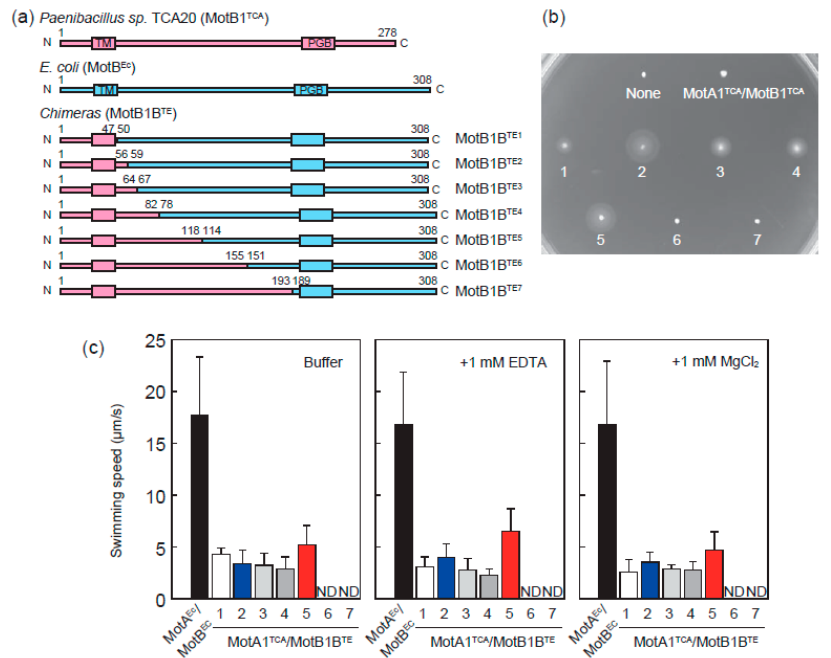
Figure 2. Characterization of chimeric stator in E. coli . ( a ) Design of a series of domain swap chimeras MotB1B TE . The region derived from MotB1 TCA and MotB Ec are colored light magenta and blue, respectively. TM and PGB represent the transmembrane and peptidoglycan binding domains, respectively. Numbers above each diagram indicate the amino acid sequence numbers. Depending on the swapping sites, chimera proteins MotB1B TE are numbered from 1–7. ( b ) Motility of E. coli cells expressing chimera stator proteins on semi-solid agar plate. The numbers correspond to chimeras in ( a ). ( c ) Swimming speed of E. coli cells expressing chimera stator proteins in phosphate buffer (left) containing 1 mM EDTA (center) and 1 mM MgCl 2 (right). ND represents that no swimming cells were detected.